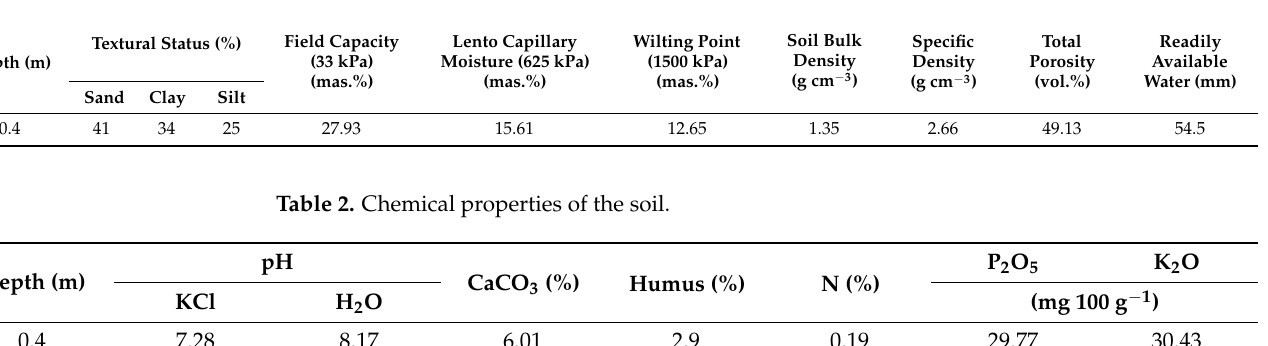
Table 1. Water and physical properties of the soil.